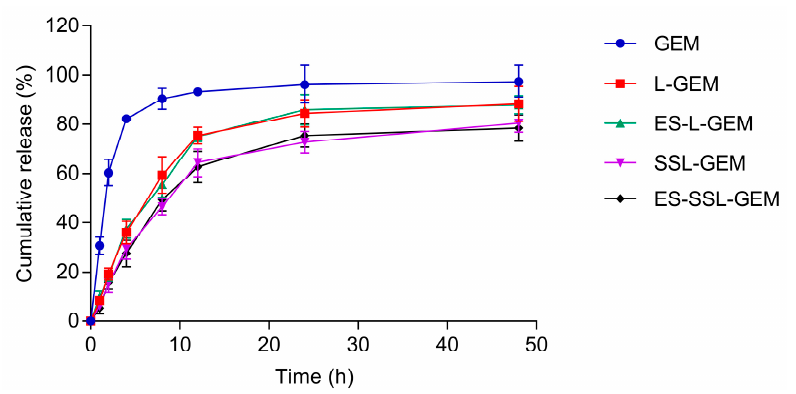
Figure 4. Cumulative release of GEM from the different liposomes in pH 7.4 PBS medium (n = 3).